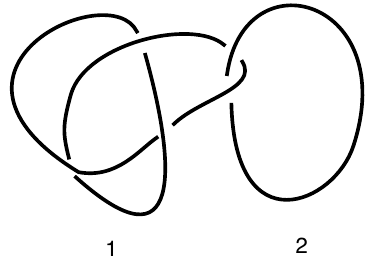
Figure 6 . A link between a trefoil knot and an unknot, i.e., the connected sum of the trefoil knot with the Hopf